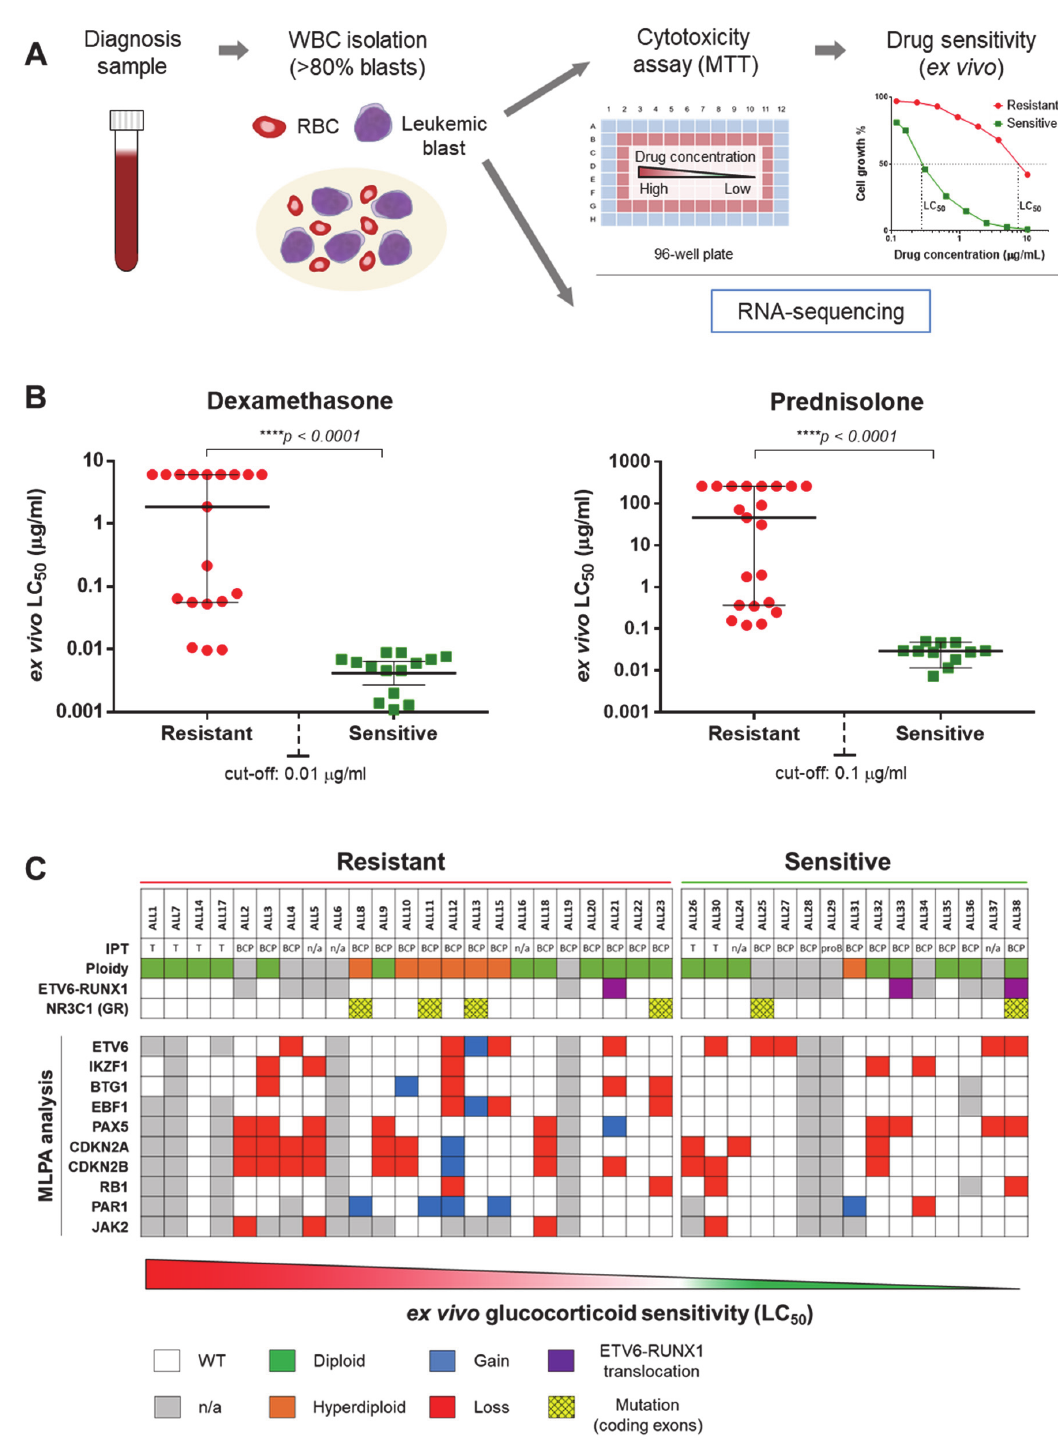
Figure 1. Overview of de novo pediatric acute lymphoblastic leukemia (ALL) patient cohort. ( A ) Schematic representation of study design. Primary childhood leukemia samples (from both peripheral blood and bone marrow) were collected at diagnosis and processed for white blood cell (WBC) isolation. Samples with blast populations > 80% were tested for ex vivo cytotoxicity (MTT) assays and processed for RNA sequencing. ( B ) Ex vivo glucocorticoid (GC) sensitivity levels. Isolated blasts were treated with Dex (concentration range: 0.0002–6.1 µg/mL) and Pred (concentration range: 0.007–260 µg/mL). After 96 h, the samples were measured by MTT assay and the median lethal concentration (LC 50 —the concentration of the drug that kills 50% of cells as compared to the control)